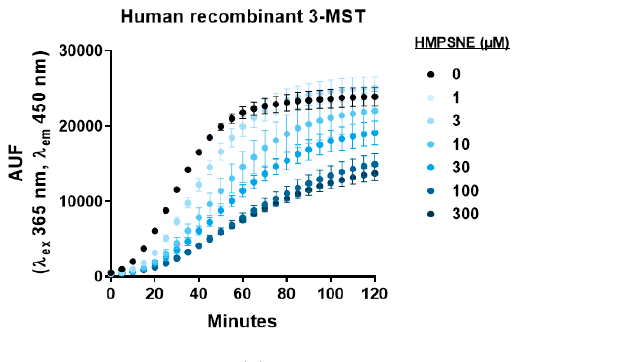
Figure 2. Human recombinant 3-MST activity in presence of 2-[(4-hydroxy-6-methylpyrimidin-2-yl)sulfanyl]-1-(naphthalen-1-yl)ethan-1-one (HMPSNE), measured with the fluorescent H 2 S probe 7-azido-4-methylcoumarin (AzMC): ( a ) Representative curves of H 2 S production after incubation with serial dilutions of HMPSNE, in presence of 2 mM 3-MP and 10 µM AzMC. Data are presented as mean ± SEM of three replicates; ( b ) Concentration-response of HMPSNE represented in percentage of control as mean ± SEM of three independent experiments.